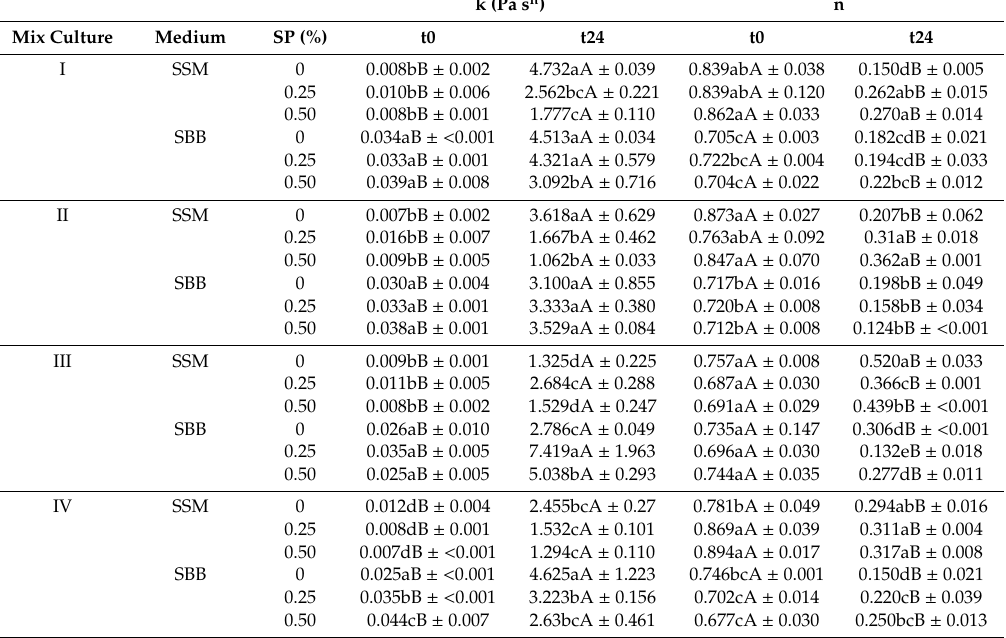
Table 3. Results of power-law rheological parameters n and k derived from equation 1, of each mix culture inoculated in skimmed milk (SSM) and soymilk